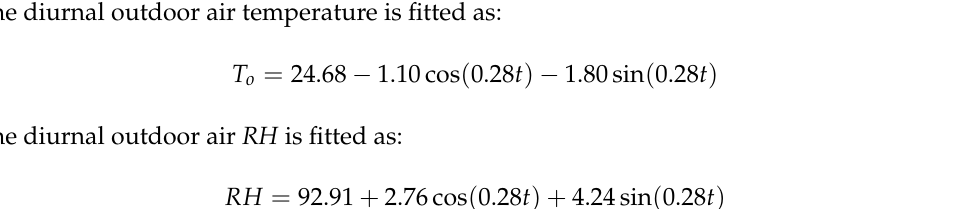
Figure 4. The diurnal variation of outdoor air temperature and RH on a plum rain day.